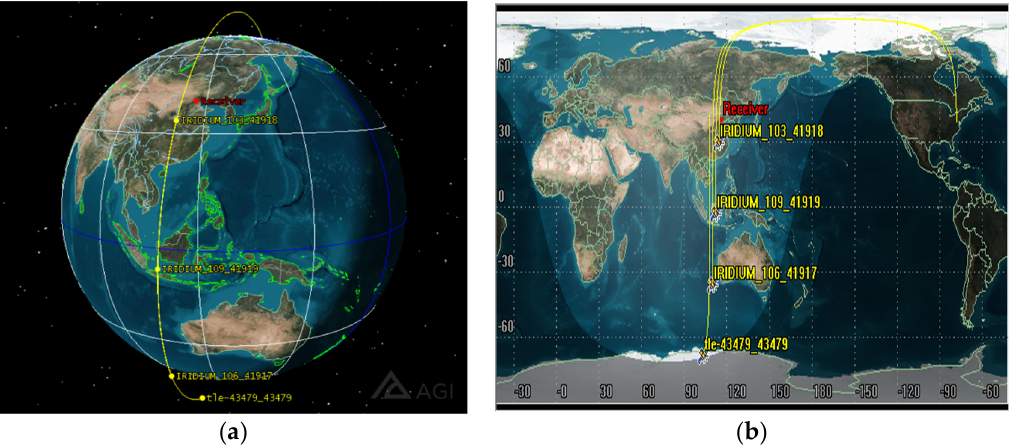
Figure 10. Simulation results of the four visible IRIDIUM NEXT satellites based on STK: ( a ) Three-dimensional (3D) graphics of the simulation result; ( b ) two-dimensional (2D) graphics of the simulation result.